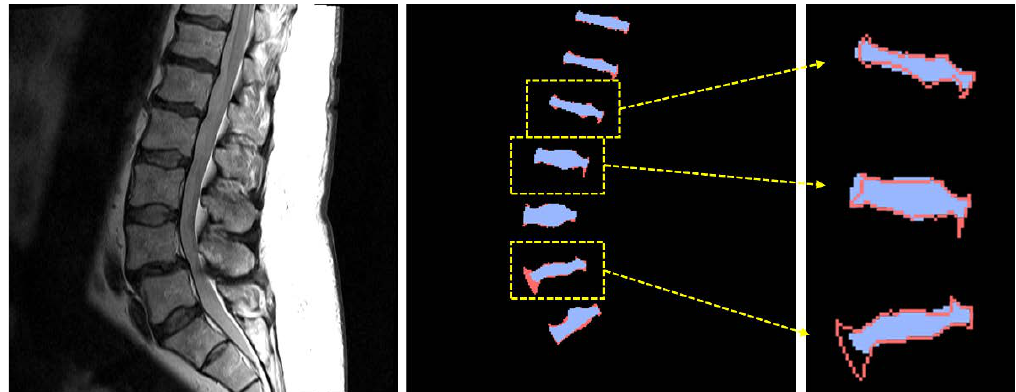
Figure 2. Intervertebral disc segmentation results from the conventional U-net. Blue areas are the results from the conventional U-net and red areas are manually segmented labels. Red lines are the boundaries of the labels.